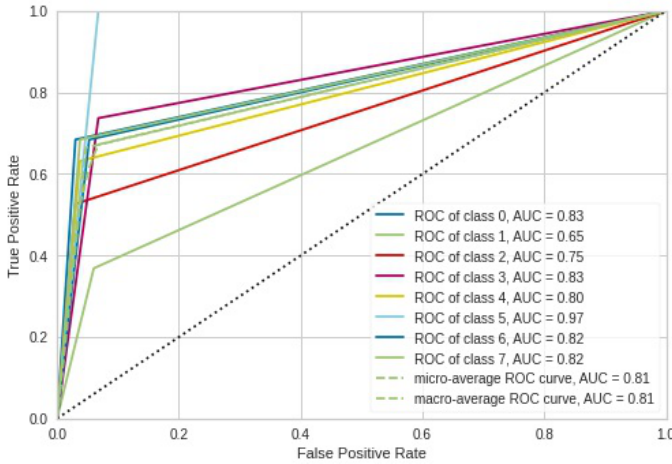
Figure 14. ROC AUC Curves for Decision-tree-based classifier.